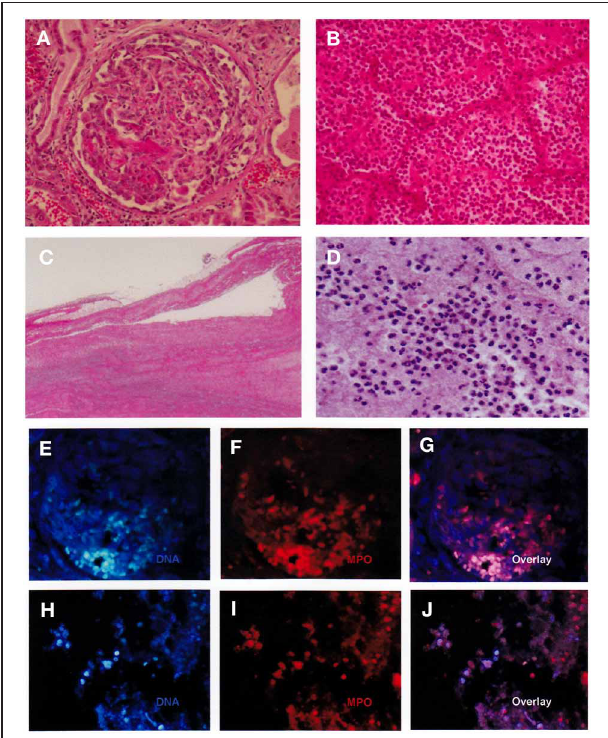
FIGURE 2 | Comparison of NETs in thrombi derived from patients with diverse diseases. In order to detect citrullinated histones in thrombi from patients with MPA (A) and other diseases [ B : bacterial sepsis, C : post-operative pulmonary embolism (PE)], immunohistochemistry was performed using anti-citrullinated H3 antibody. Original magnification: × 200 (A–C) . (D) Comparison on the amount of NETs among thrombi derived from patients with MPA (present case), bacterial sepsis, and post-operative PE. ∗ p < 0 . 05, ∗∗ p < 0 .